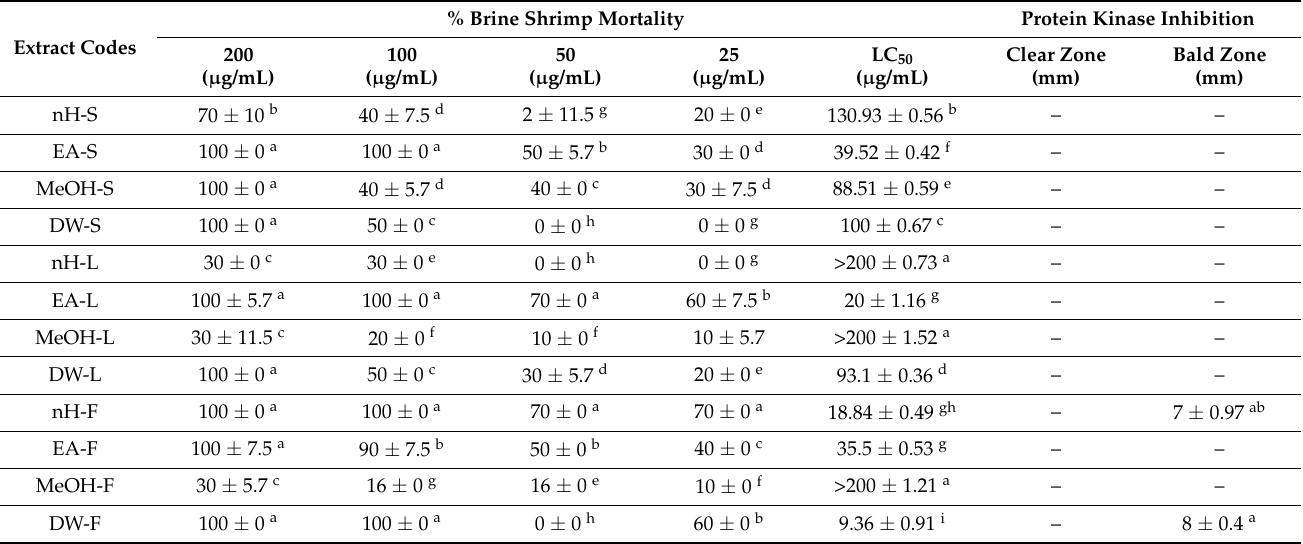
Table 3. Brine shrimp lethality and protein kinase inhibition potential of crude extracts of P. roxburghii .